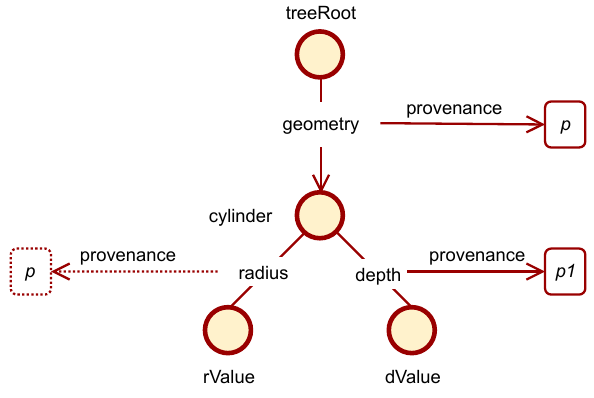
Figure 2. Propagation of the provenance information ( p ) to the radius component property of a tree root’s geometry.